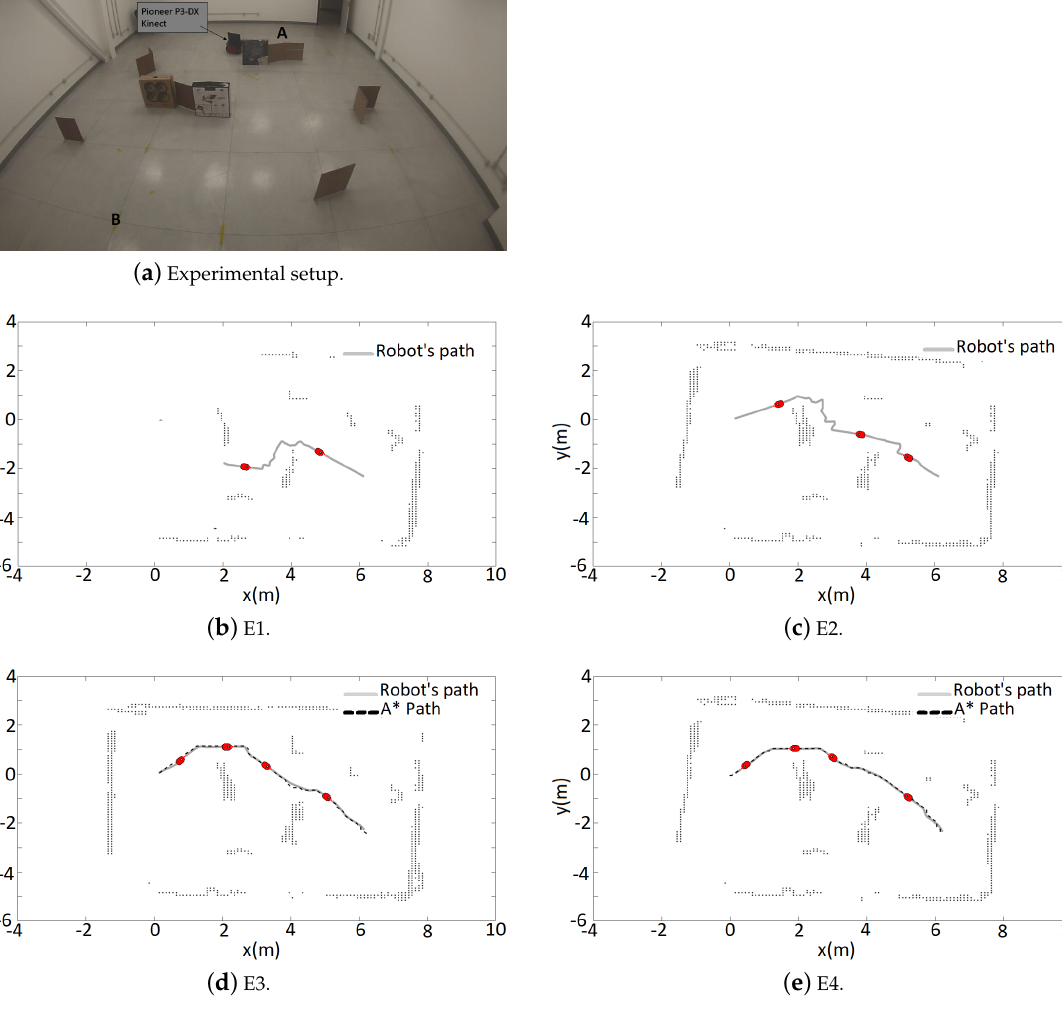
Figure 6. Navigation and